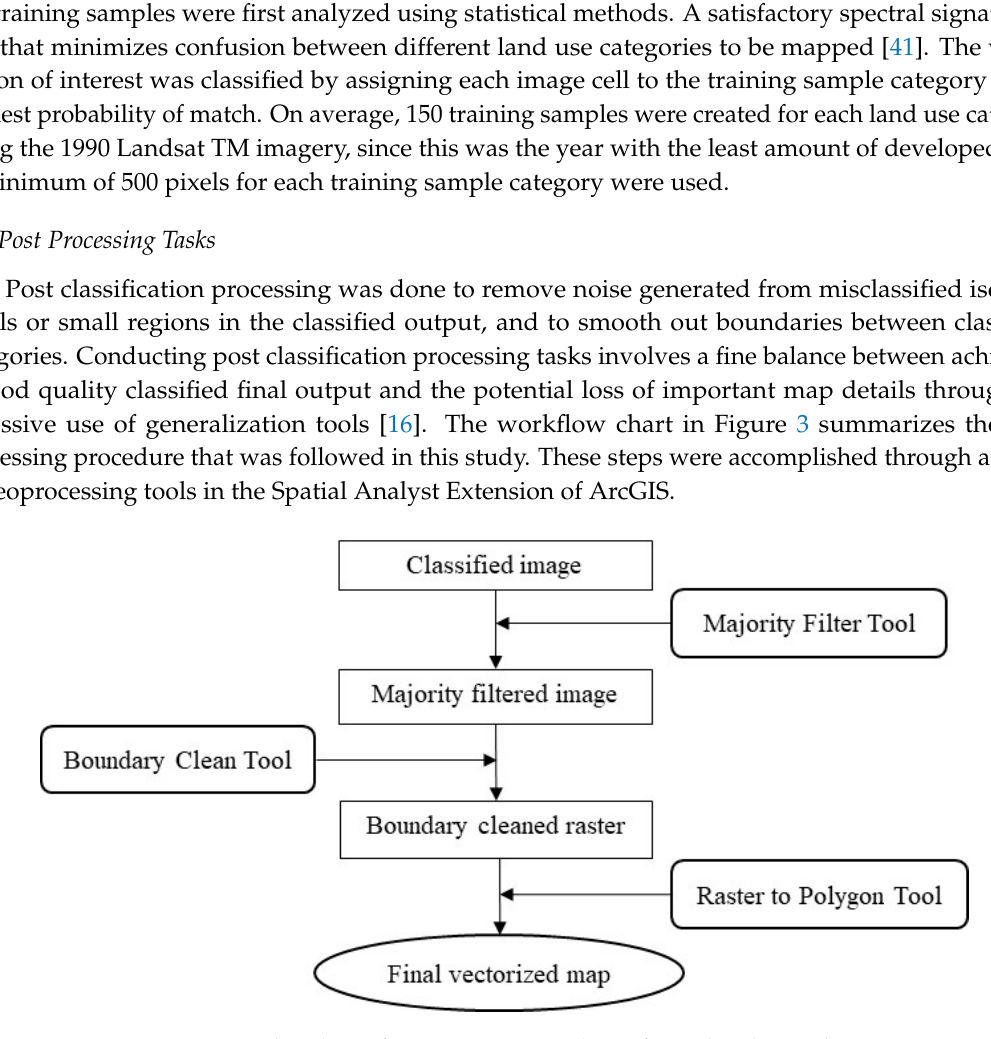
Figure 3. Flowchart of post processing tasks performed in this study.